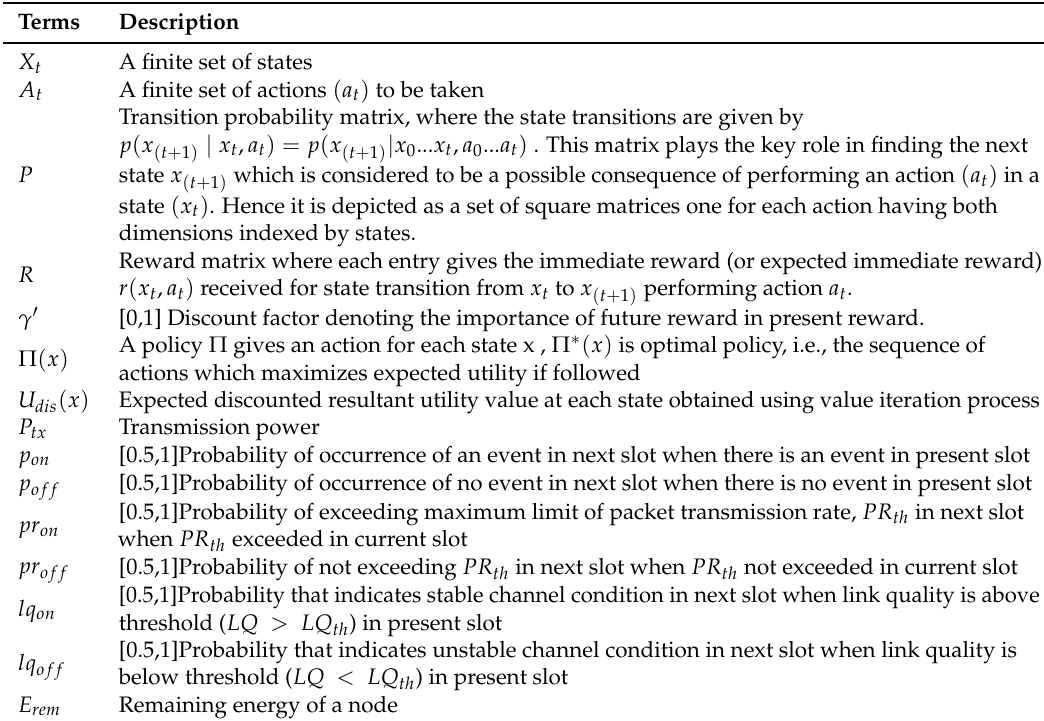
Table 2. Description of frequently used